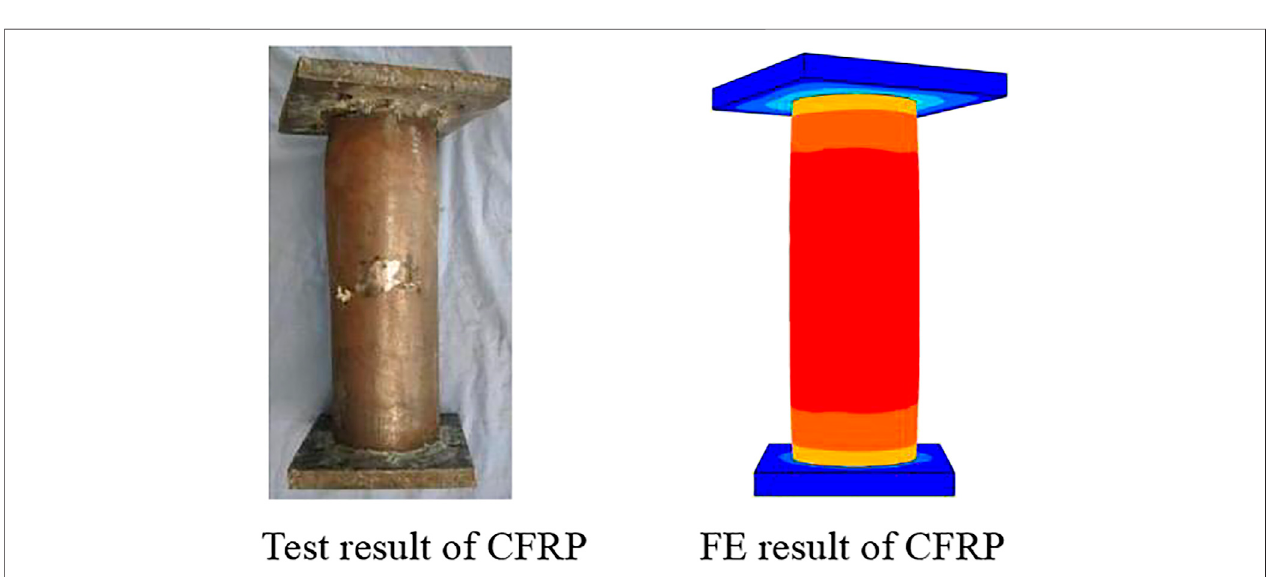
Figure 12 is Grid generation of all materials.